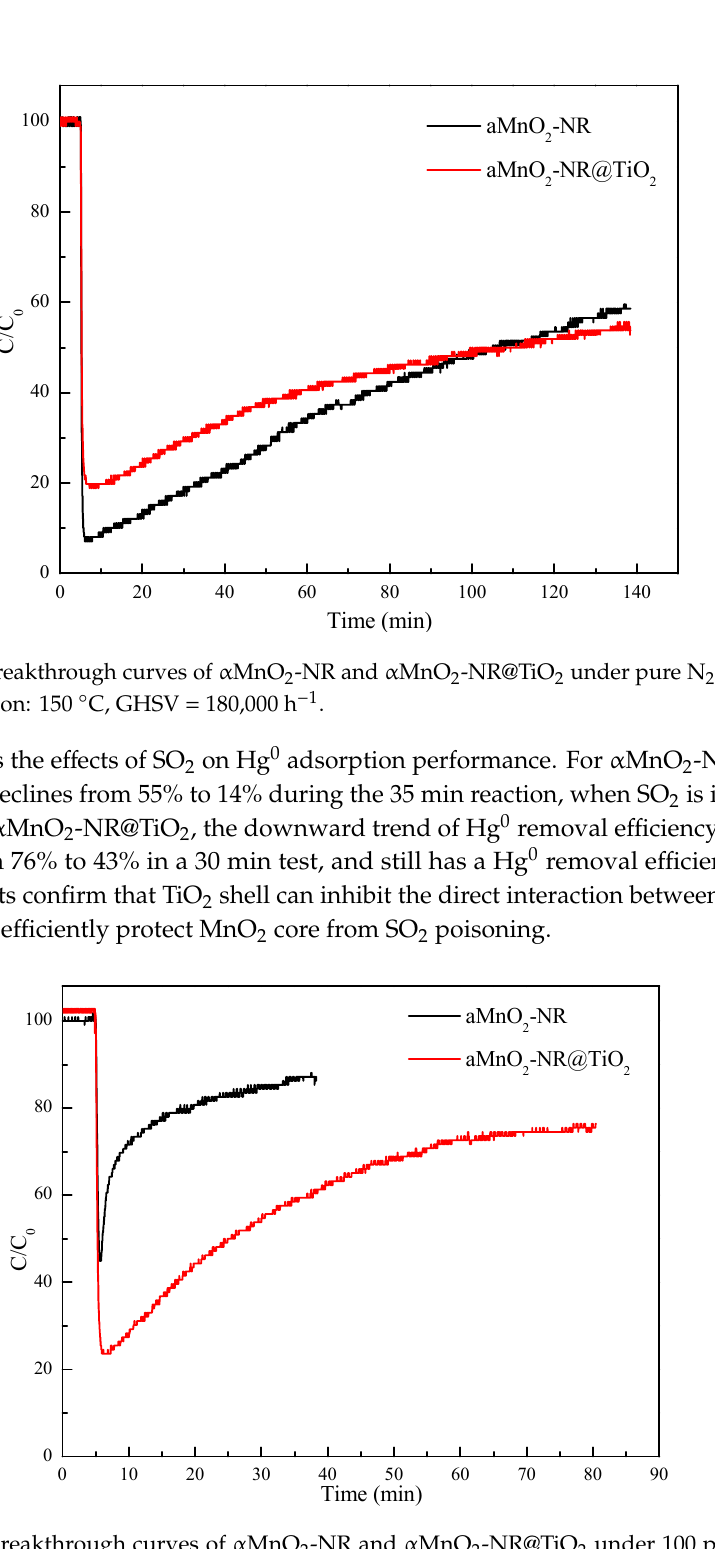
Figure 6. After 10 h Hg 0 adsorption test, αMnO 2 -NR@TiO 2 reaches a Hg 0 adsorption equilibrium. And